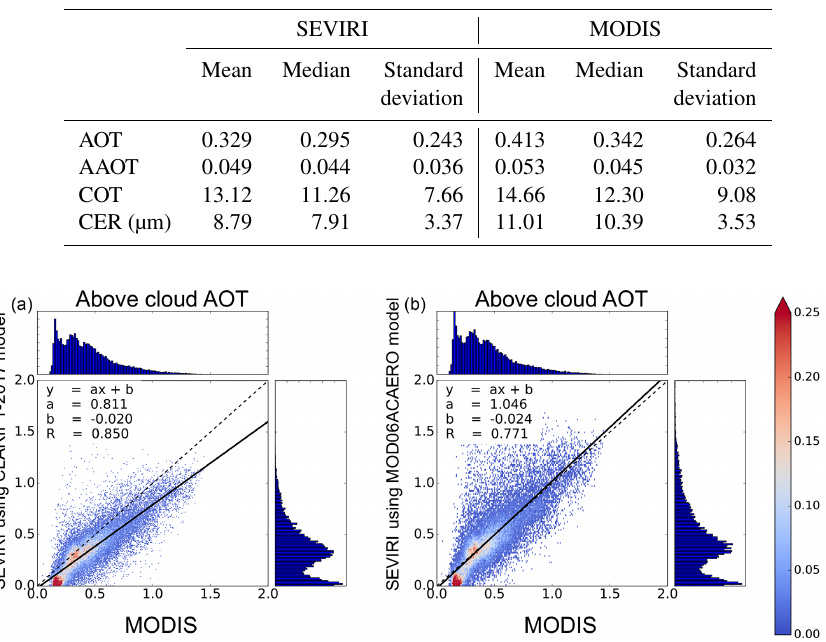
Table 1. Summary statistics of the aerosol and cloud properties retrieved by SEVIRI and MODIS compared in Fig. 3.